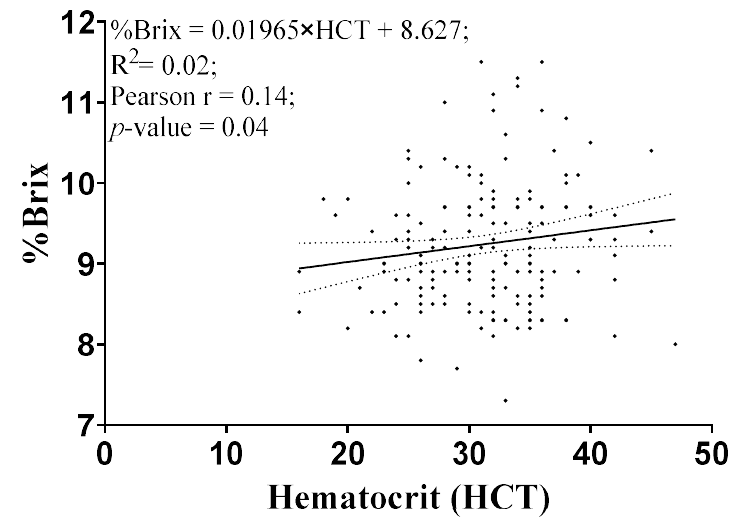
Figure 1. Linear regression analysis between the hematocrit concentration and serum % Brix. The solid line represents the linear regression, and the dotted lines represent the 95%